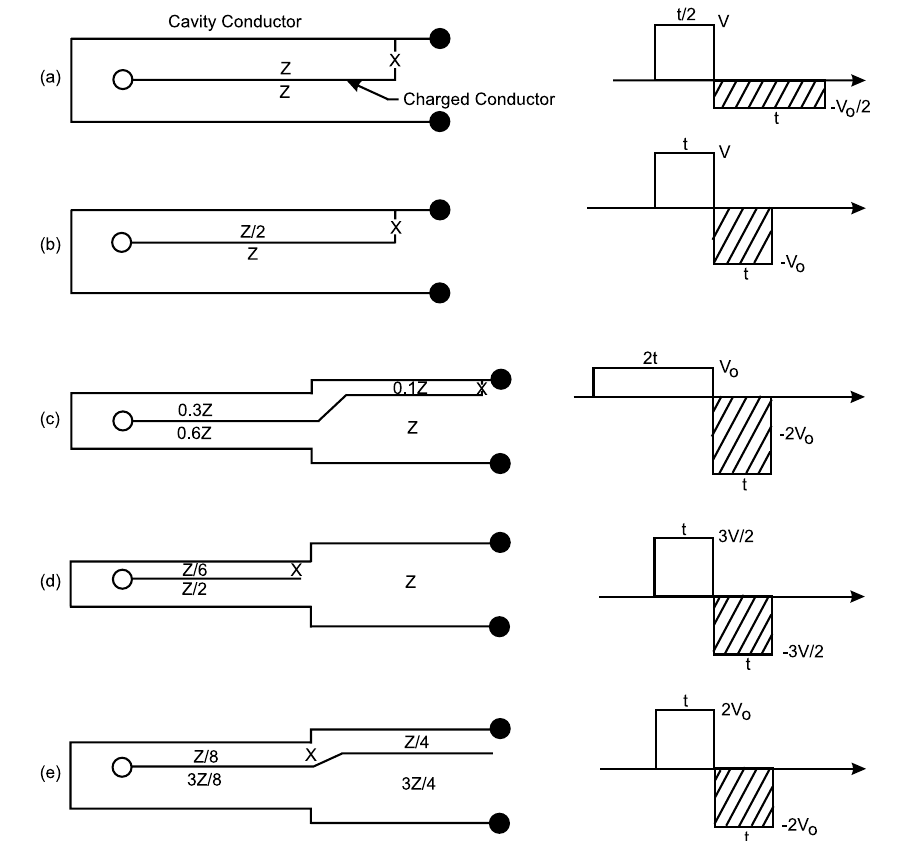
FIG. 7. Air-core bipolar pulse line accelerator cavities. (All have internal conductors charged to a voltage V , output impedances Z , and beam pulse durations t